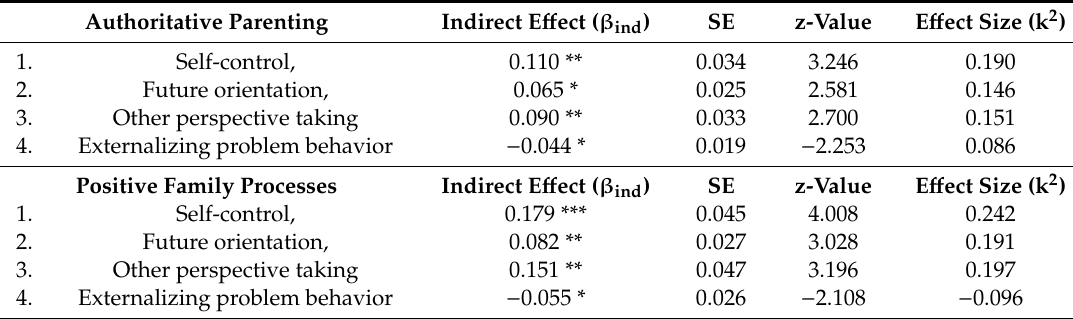
Table 5. Indirect e ff ects of youth self-esteem on the relationships between authoritative parenting and positive family processes in relation to youth self-control, future orientation, other perspective taking and externalizing problem